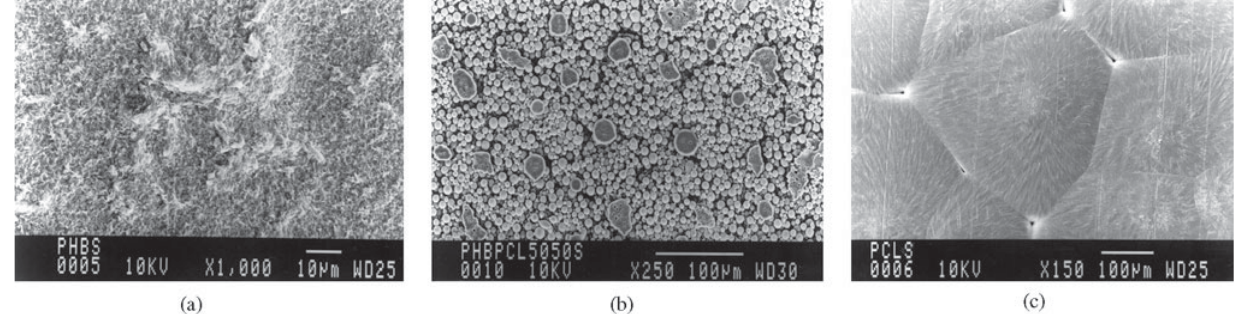
Figura 10. Micrografias de SEM da superfície superior das blendas de P(3-HB)/PCL e dos homopolímeros: a) P(3-HB); b) P(3-HB)/PCL (50/50); c)